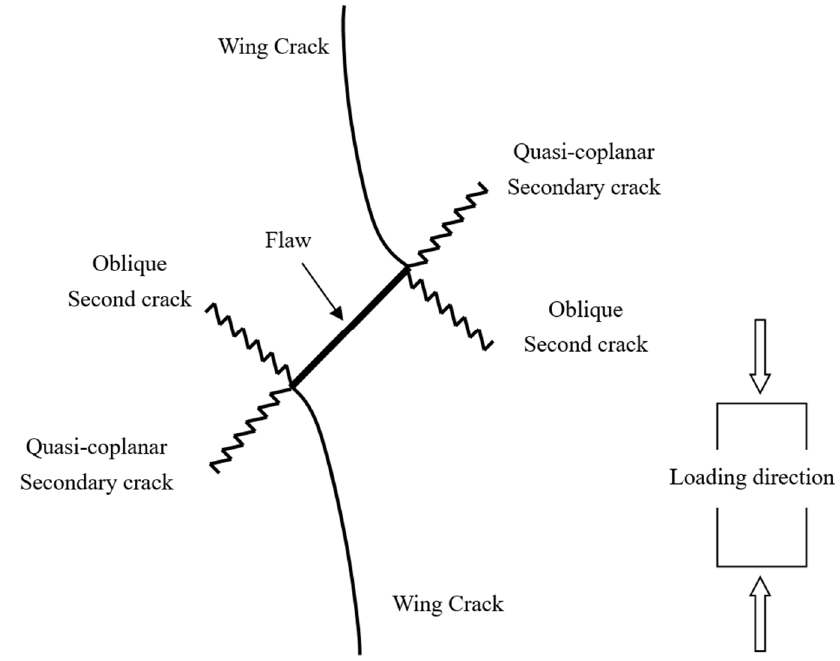
Figure 3. Crack propagation from pre-existing crack subjected to compression.